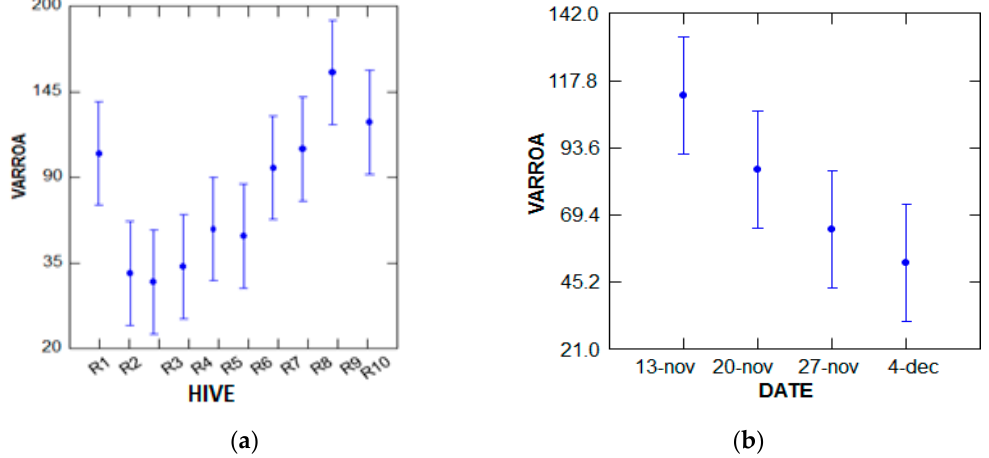
Figure 2. The variance analysis of the number of varroa that died naturally. ( a ) Hive; ( b ) Date.